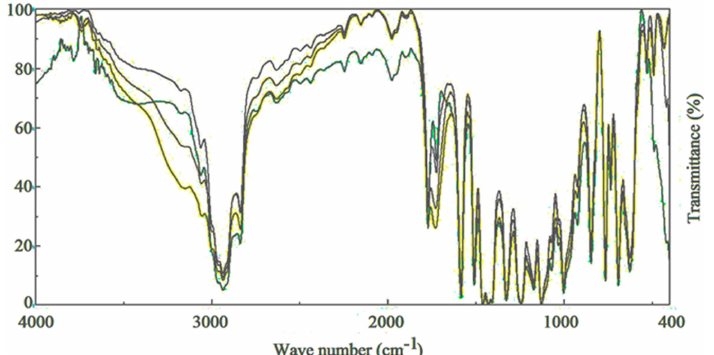
Figure 1. Change in IR spectrum of PVC film (30 µm) in the presence of the III compound (numbers in the spectra are the irradiation times in hours).